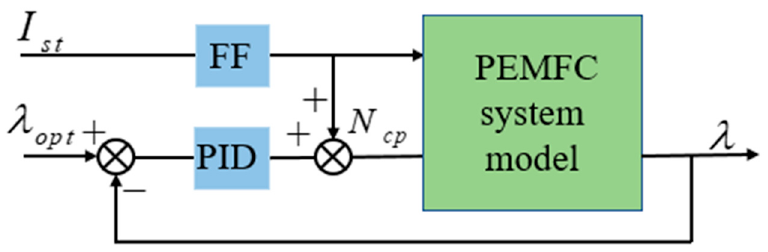
Figure 7. Structure of feedforward plus PID controller.